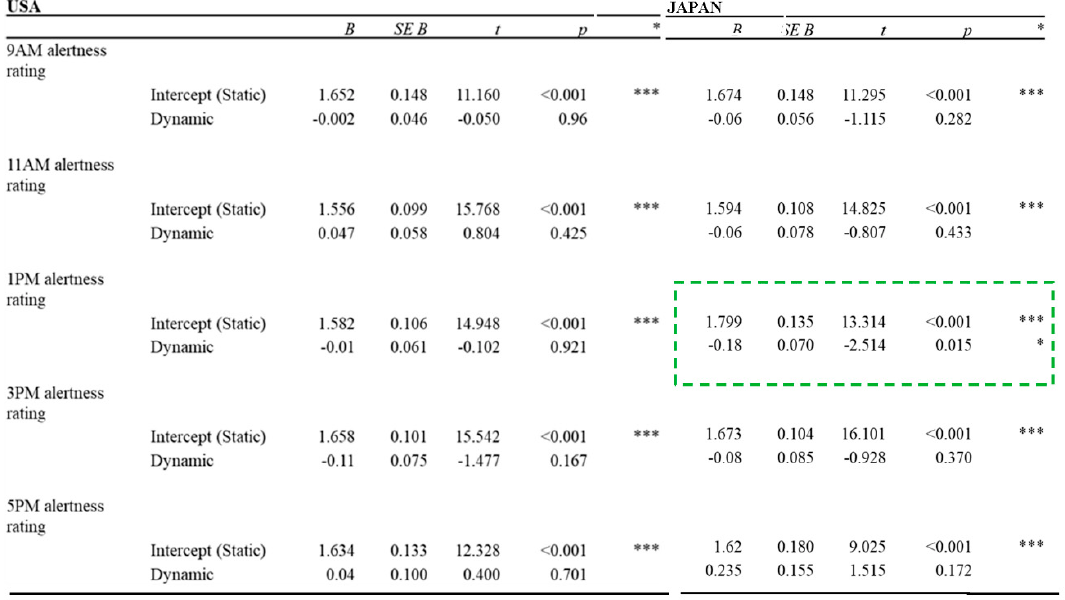
Table 4. Results for daily alertness measurement.